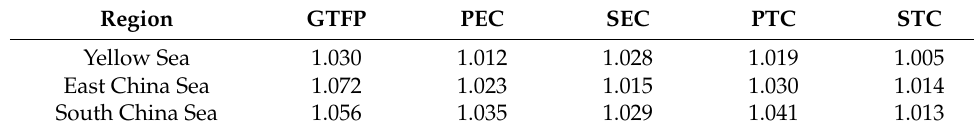
Table 3. MGTFP and Zofio Index decomposition of Mariculture in three regions, 2003–2020.